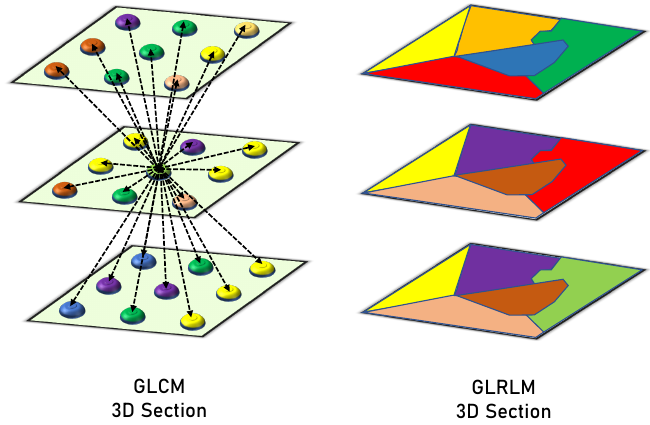
Figure 4. Graphical comparison between the GLCM and